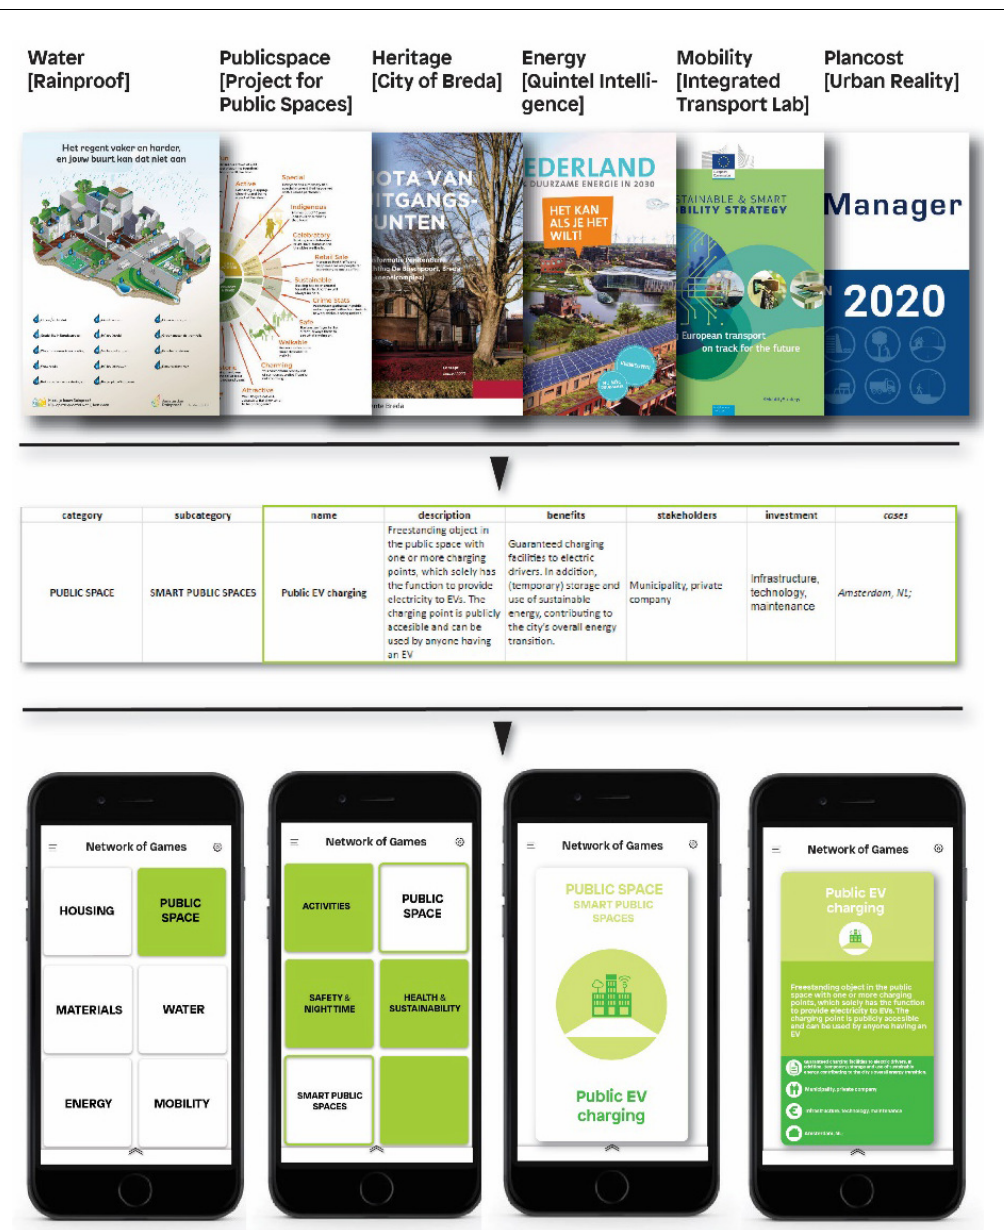
Figure 3. Original data sources, datasets excel sheet documentation, and visual translation of datasets as game